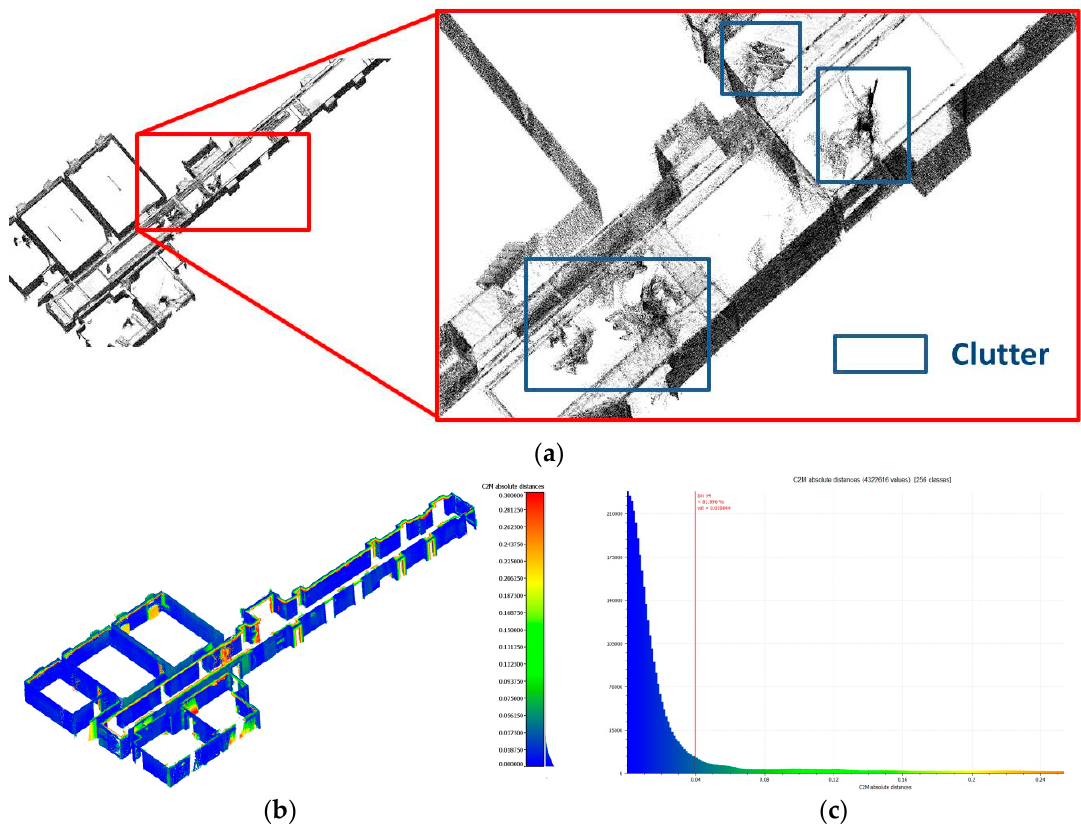
Figure 15. Corridor dataset: in the middle of the corridor due to the presence of people it presents a highly cluttered area ( a ), point clouds colored with points-to-model unsigned distances for walls ( b ), and histogram of residuals between the reconstructed model and point cloud for walls ( c ).